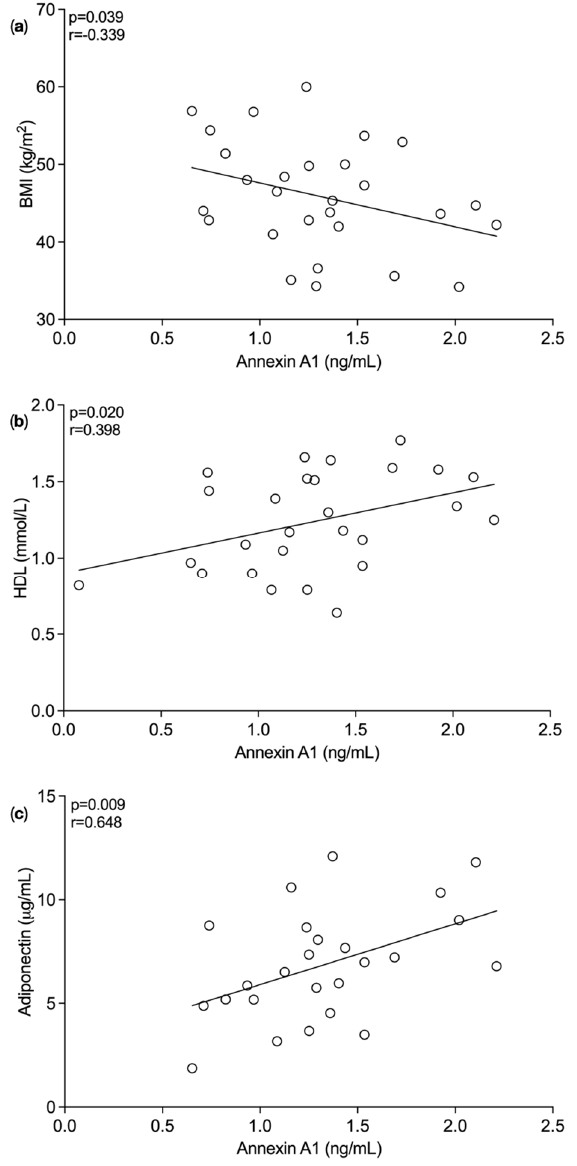
Figure 2. Correlation between plasma concentration of annexin A1 (ng/mL) and biomarkers in bariatric surgery patients. ( a ) Plasma concentration of Annexin A1 significantly inversely correlated with body mass index (BMI) (kg/m 2 ) ( p = 0.039, r = − 0.340), ( b ) significantly positively correlated with plasma concentration of high-density lipoprotein (HDL) (mmol/L) ( p = 0.020, r = 0.398) and ( c ) significantly positively correlated with plasma adiponectin concentration ( p = 0.009, r = 0.468). One-tailed Pearson correlation coefficient was used to statistically analyse the data.